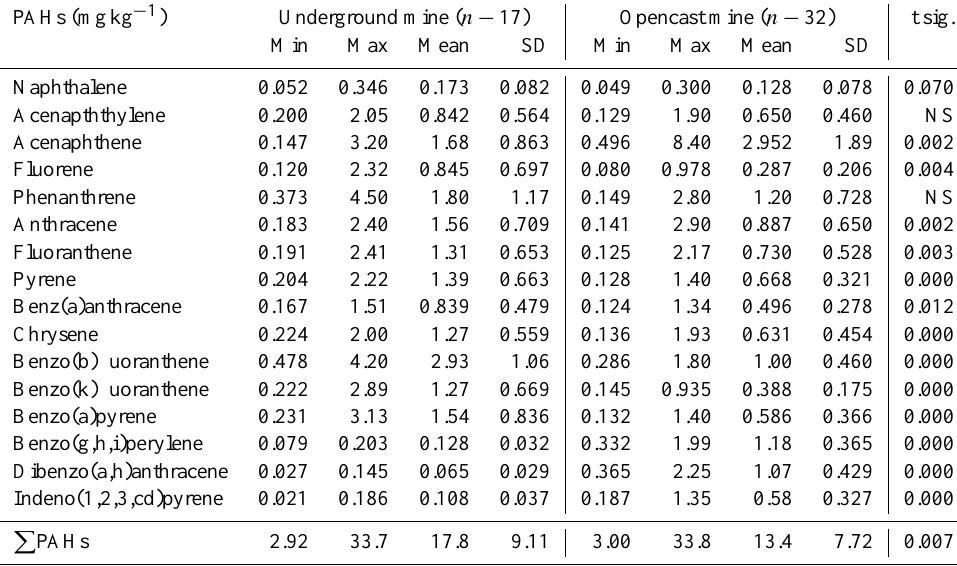
Table 3. Soil PAH contents in the opencast and underground mining site. PAHs (mgkg − 1